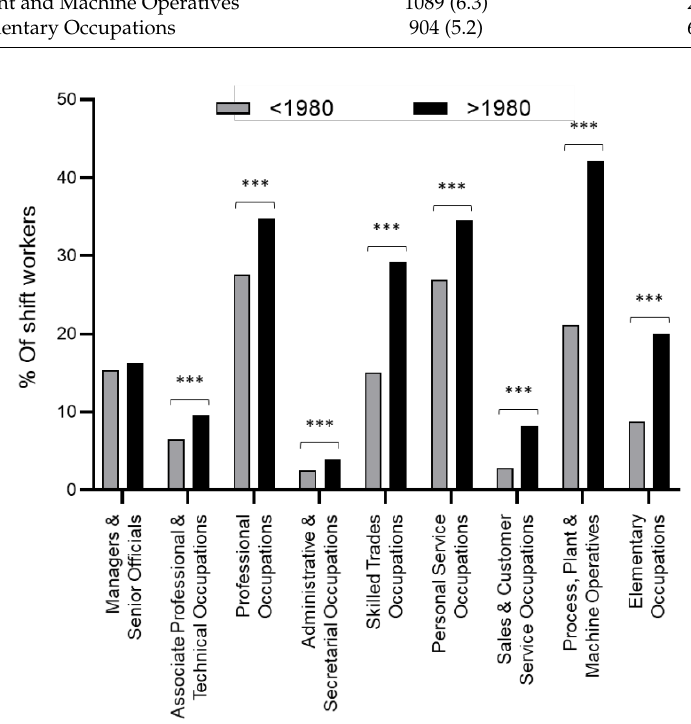
Figure 1. Percent of shift workers among job categories before and after 1980. ***: p -value <0.001.